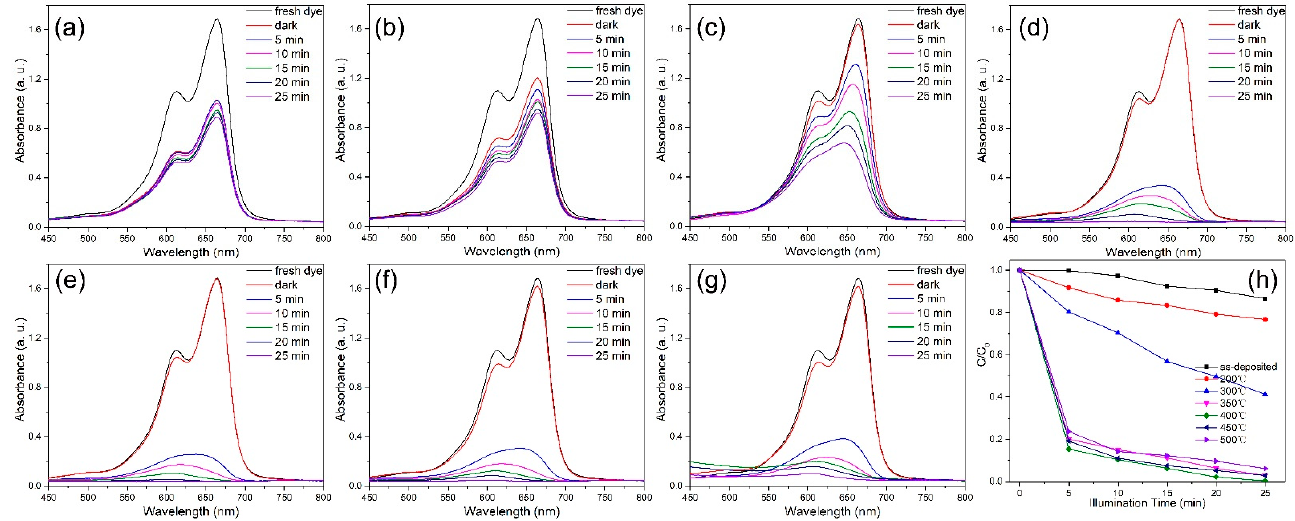
Figure 8. UV-vis absorbance spectra of MB solutions treated with the photocatalyst prepared at ( a ) RT and annealed at different temperatures for different periods: ( b ) 200, ( c ) 300, ( d ) 350, ( e ) 400, ( f ) 450, and ( g ) 500 °C. ( h ) Degree of photodegradation of MB annealed at different temperatures.